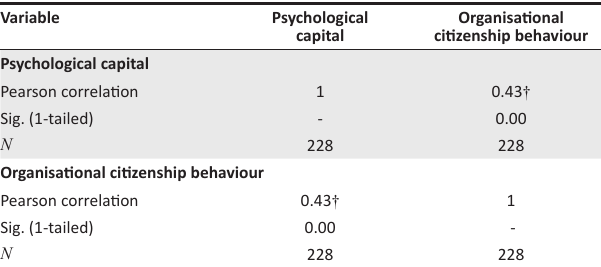
TABLE 2: Correlation of psychological capital and organisational citizenship behaviour. Variable